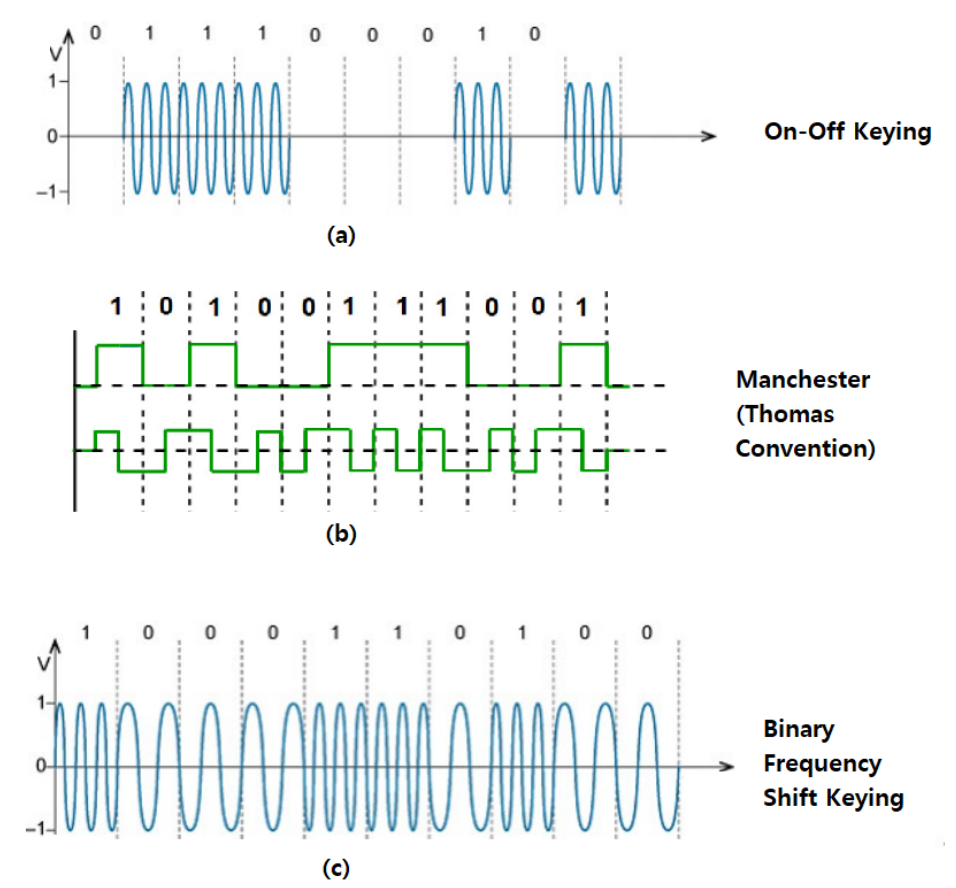
Figure 3. Common encoding methods for covert channels: ( a ) On–off keying, ( b ) Manchester Encoding, and ( c ) Binary Frequency Shift